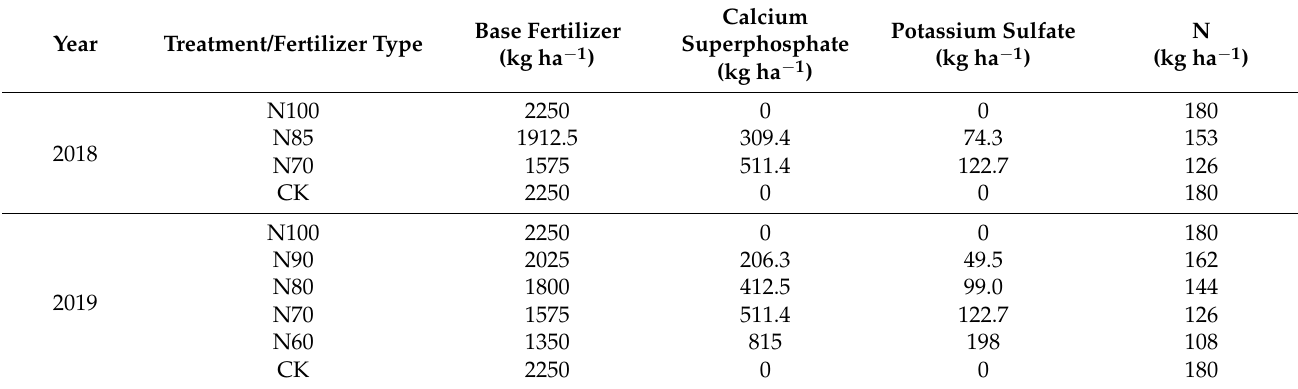
Table 3. Conversion of fertilizer